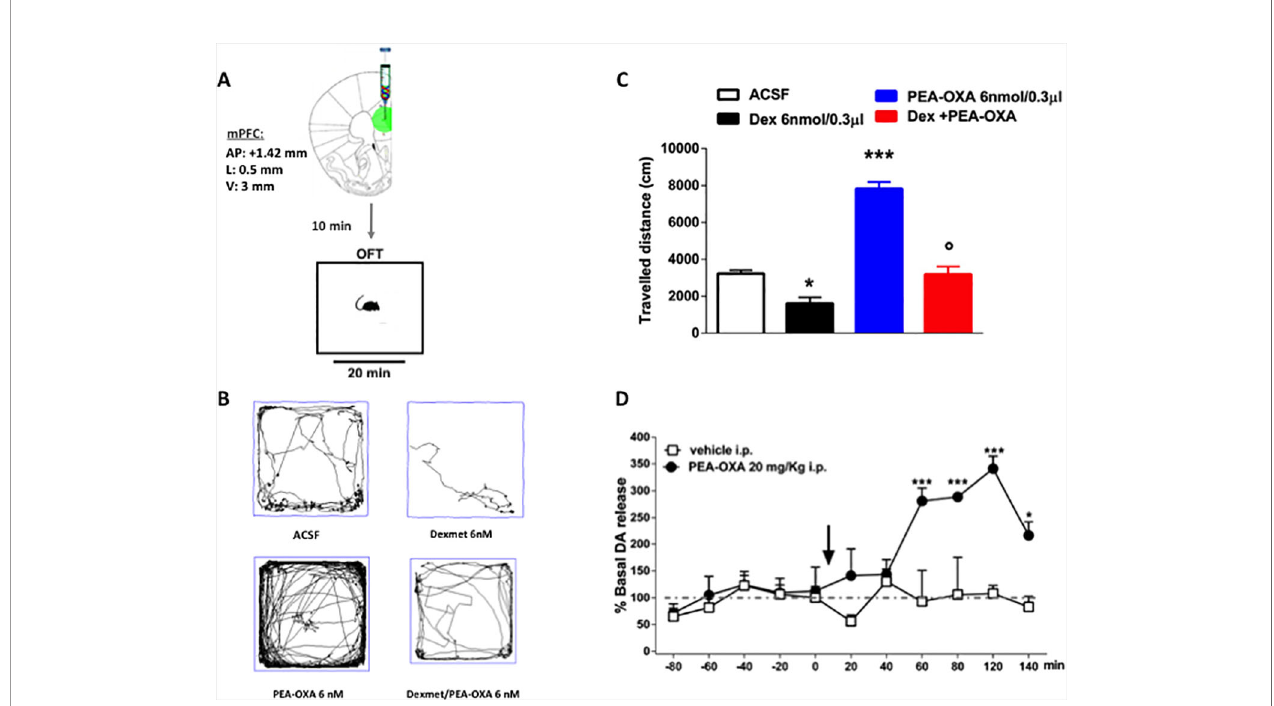
FIGURE 8 | Effects of single injection of PEA-OXA (6 nmol/0.3 m l i.c.v. and 20 mg/kg i.p.) on dexomedetomidine-induced decreased locomotor activity and on Dopamine extracellular levels in m PFC of Na ϊ ve mice. (A) Representation of coronal sections of the mouse brain with the cannula placement in mPFC, (B) Representative traces of mouse movement during an open fi eld test, (C) Total distance traveled in OFT. Data are represented as mean ± SEM of 3 mice per group. *P < 0.05 and ***P < 0.001 indicate signi fi cant differences compared to ACSF. P < 0.05 indicate signi fi cant differences compared to PEA-OXA 6 nM. P < 0.05 was considered statistically. One-Way ANOVA, followed by Tukey's post hoc test for multiple comparisons test was performed. (D) Dopamine extracellular levels in mPFC of Na ϊ ve mice. Each point represents the mean ± S.E.M of four animals per group. *P < 0.05 and ***P < 0.001 indicate signi fi cant differences versus time 0. °P < 0.05 indicates signi fi cant differences compared to PEA-OXA 6 nmol/0.3 m l. P < 0.05 was considered statistically. Two-Way ANOVA, followed by Bonferroni's post hoc test for multiple comparisons test was